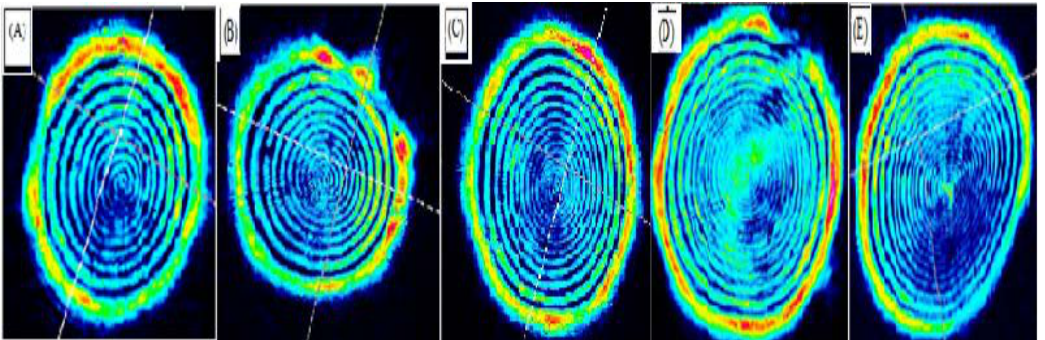
Fig.13: Non-linear diffraction pattern produced by SWCNTs at volume fraction 13x10 -5 at laser intensity (A) 130.41, (B) 169.81, (C) 238.31, (D) 285.69, and (E) 353.38 W / cm 2 .